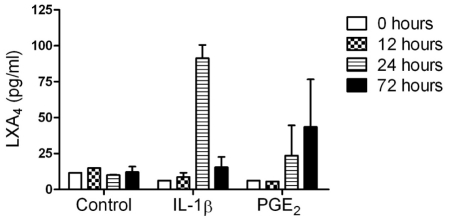
The effect of pro-inflammatory mediators on release of lipoxin A4 (LXA4) in media from tendon explants.Data represent average LXA4 levels from 3 normal (uninjured) horses. LXA4 levels were determined at time points 0, 12, 24 and 72 hours after stimulation and compared to non-stimulated controls. There was a difference in the temporal response showing increased LXA4 release 24 hours after stimulation with IL-1β (P<0.001) and 72 hours after stimulation with PGE2 (P = 0.048) compared to non-stimulated controls. Values for significance were based on a linear model.